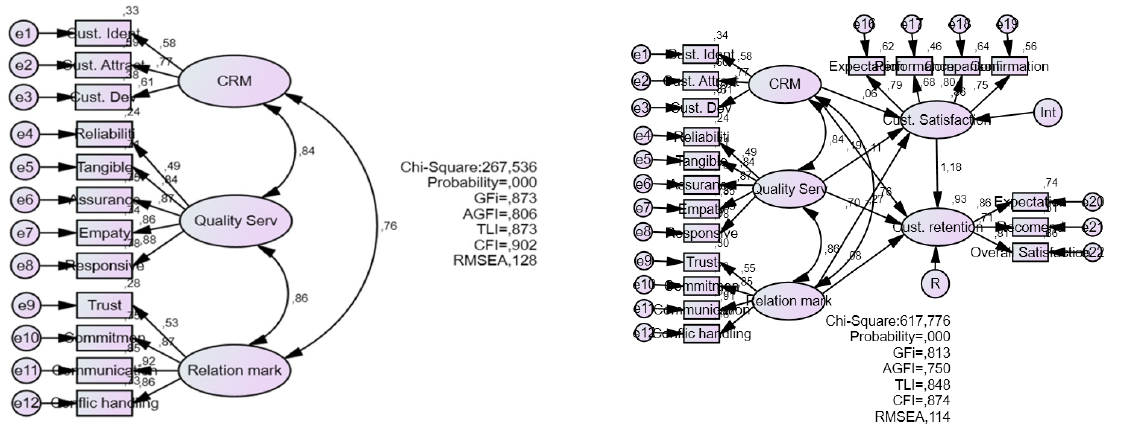
Fig. 3. Measurement Model Fig. 4. Goodness of